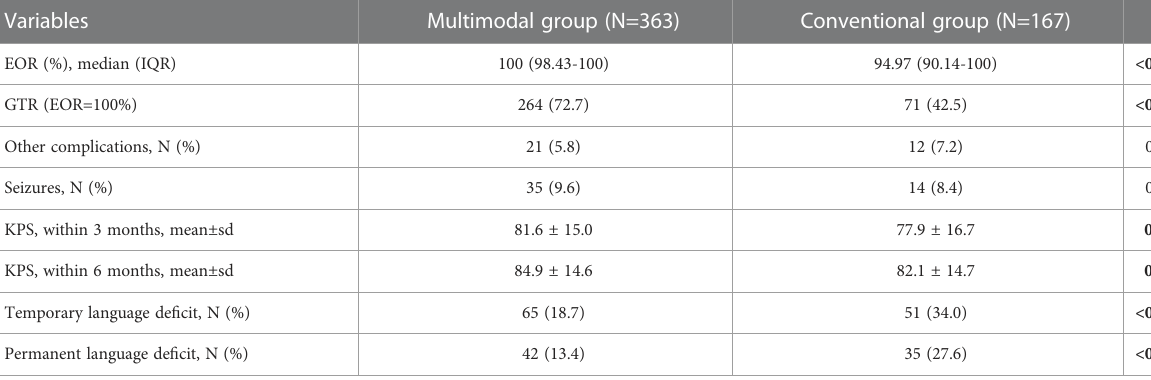
TABLE 1 Comparison of outcomes between multimodal and conventional